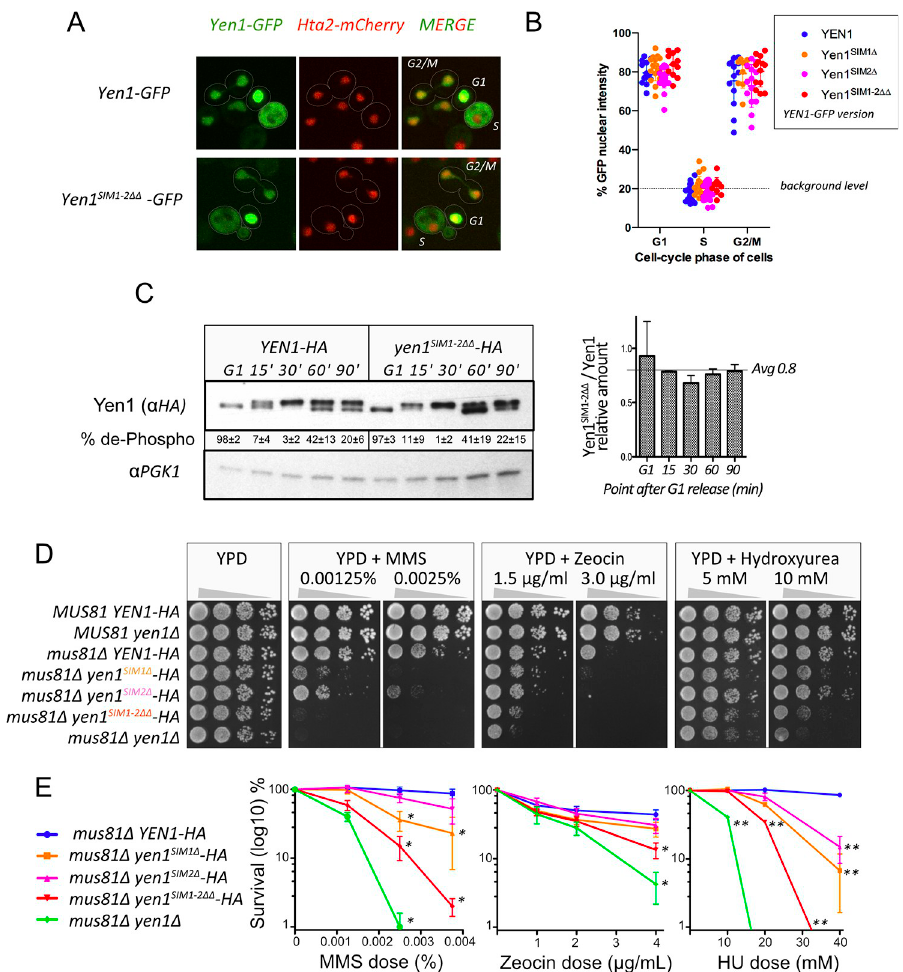
Fig 2. Mutation in Yen1 SIMs has no impact to its CDK1 regulation and nuclear shuttling but sensitizes cells to DNA damage. (A) Cells carrying an endogenous histone Hta2-mCherry marker and chromosomally–HA tagged versions of Yen1 wild-type and the different SIM mutants were transformed with a plasmid carrying an equivalent version of Yen1 fused with GFP at its C-terminal region. Cells were grown on selective media and observed using a spinning-disk microscope after a brief induction with galactose. Shuttling of the protein from cytoplasm to the nucleus can be observed in representative fields displaying cells with nuclear excluded Yen1 (S-phase and early G2-M) and nuclear localized Yen1 (anaphase to G1) for the indicated GFP-tagged proteins. (B) Quantification of the relative amount of GFP signal detected into the nucleus over the overall signal for the indicated strains in cells classified by their cell-cycle status (C) Strains with a chromosomally inserted copy of–HA tagged wild-type Yen1 or its double SIM mutant (Yen1 SIM1-2 ΔΔ ) were synchronized with alpha factor and released into fresh medium to monitor the modification of the protein through the cell cycle by immunoblot (left). Both unmodified and phosphorylated Yen1 are indicated. Average levels of endogenous Yen1 were normalized with PGK1 protein in triplicate experiments (right). (D) Sensitivity to different DNA damaging agents and drugs was determined by spotting serial dilutions of strains carrying different Yen1 mutants in its SIM in a MUS81 deleted background for the indicated media. (E) Survival curves to the agents tested in (C) were established by counting colony forming units of the different strains after plating in YPD containing the indicated doses of drugs in replicate trials. Survival was normalized per trial with its respective control YPD counts and the average survival is plotted in the graphs (+/- SEM). Significance was estimated by the student T-test at P < 0.05 ( � ) and P < 0.01 ( �� ), see S3 Table. Additional data related to this figure are found in S2 Fig. type strain [13], we found that in a dna2 Δ pif1 Δ background the SIM defective allele does not increase the already strong sensitivity of cells to DNA damaging agents like MMS or HU (S4 Fig).